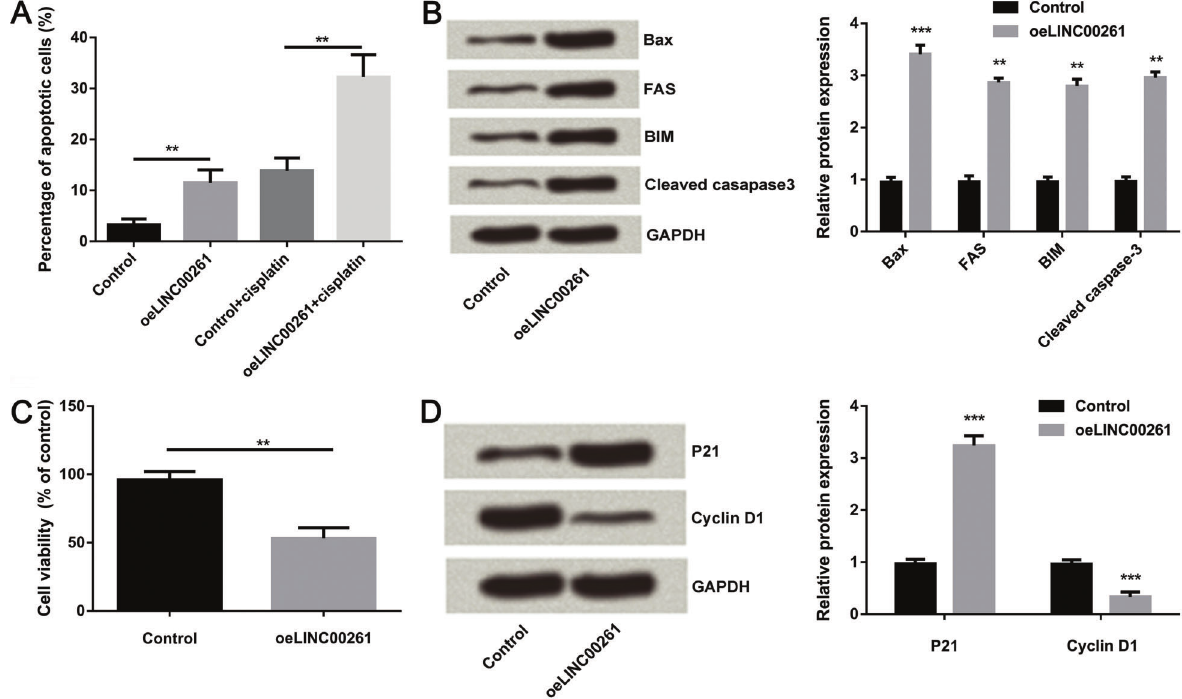
Figure 4. Effects of LINC00261 overexpression on cell viability and cell apoptosis. A , LINC00261 overexpression promoted cell apoptosis. B , LINC00261 overexpression promoted expression of apoptosis-related proteins. C and D , LINC00261 overexpression inhibited colon cancer cell viability and cycle related proteins. Oe: overexpression. Data are reported as means ± SD. **P o 0.01; ***P o 0.001